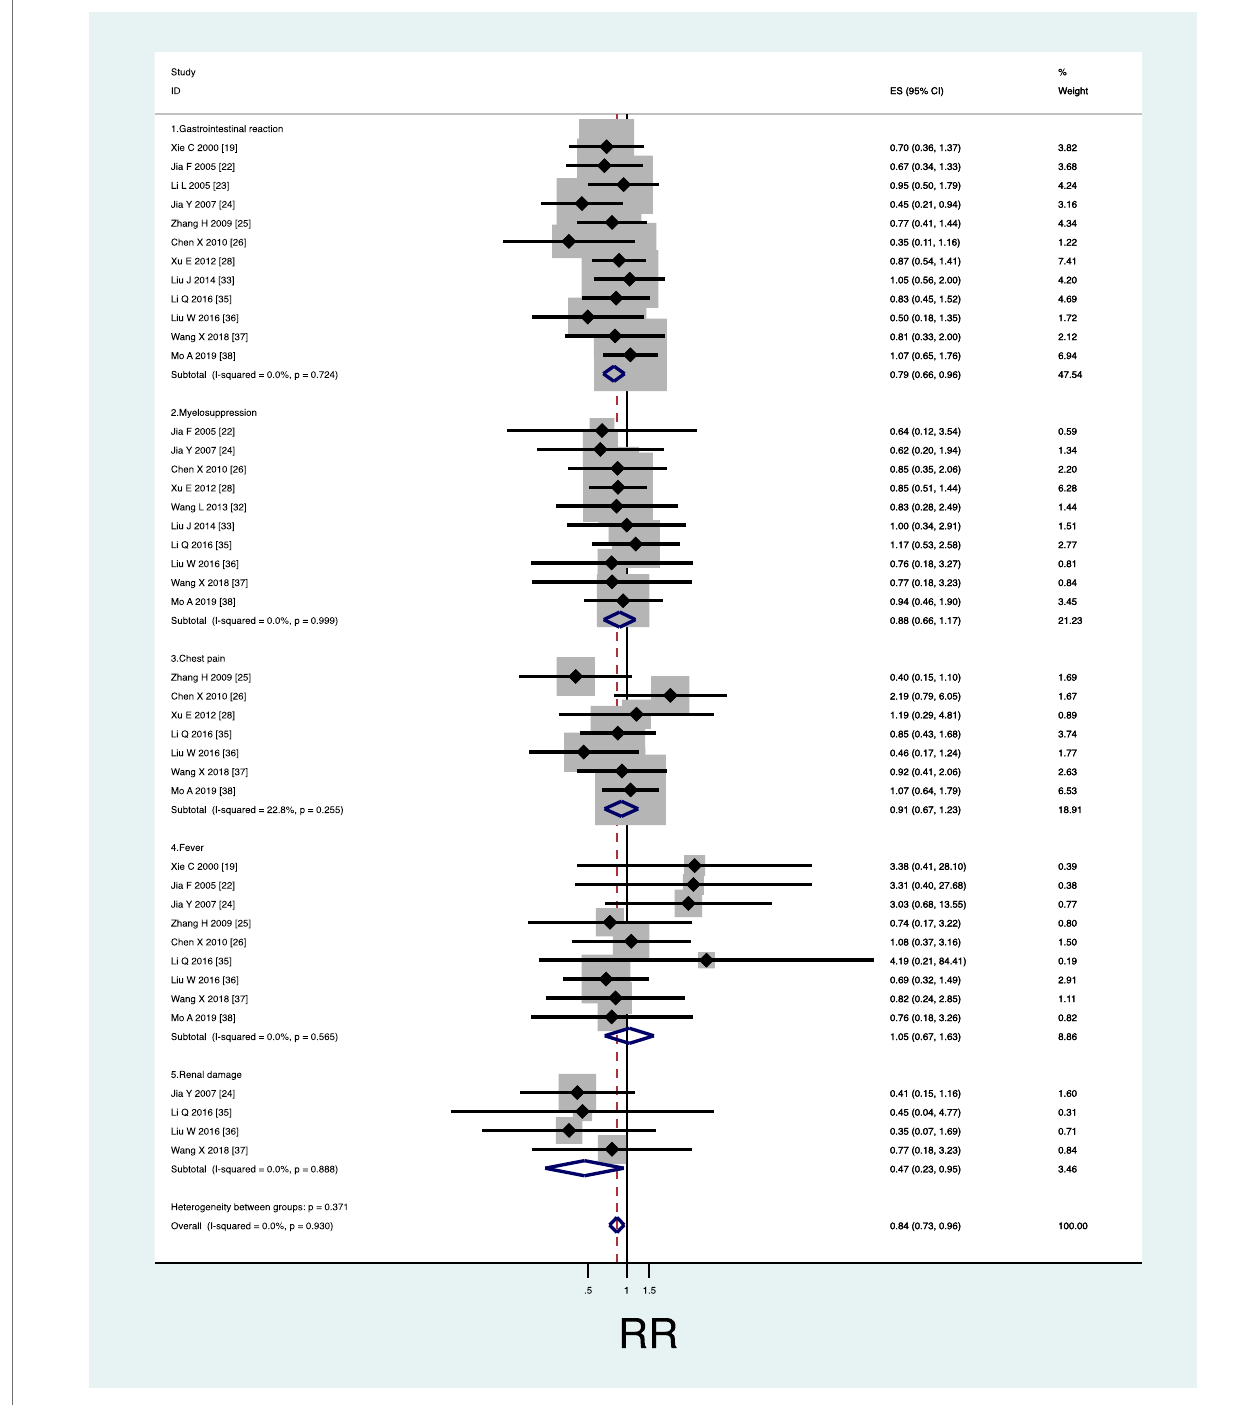
FIGURE5| SafetyevaluationofKLTIcombinedwithanotheragentversusanotheragentalonebythoracicperfusionforcontrollingMPE. (A) TheKLTIcombination therapydisplayedalower incidence rateofgastrointestinal reactions than theproject ofother agents alone; (B) Nodifference in incidence rate ofmyelosuppression was testi fi ed between KLTI combined with other agents and other agents alone; (C) No difference in incidence rate of chest pain was testi fi ed between KLTI combined with otheragentsandotheragentsalone; (D) Nodifferenceinincidencerateoffeverwastesti fi edbetweenKLTIcombinedwithotheragentsandotheragentsalone; (E) Nodifference inincidencerateofrenal damagewastesti fi ed betweenKLTI combinedwithotheragentsand otheragentsalone.RR, Riskratio;KLTI,Kanglaite injection.